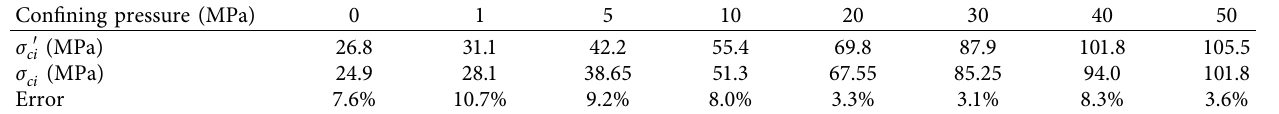
Table 6: Values of σ ci ′ , σ ci , and error under different confining